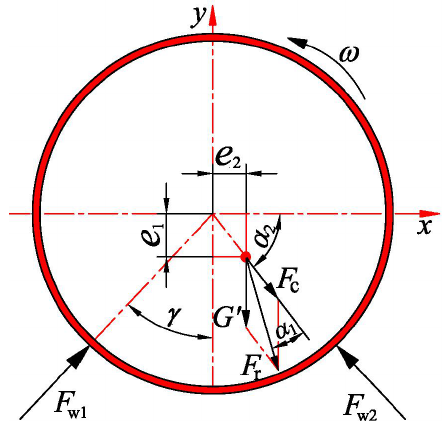
Figure B1. Force analysis of the mixing